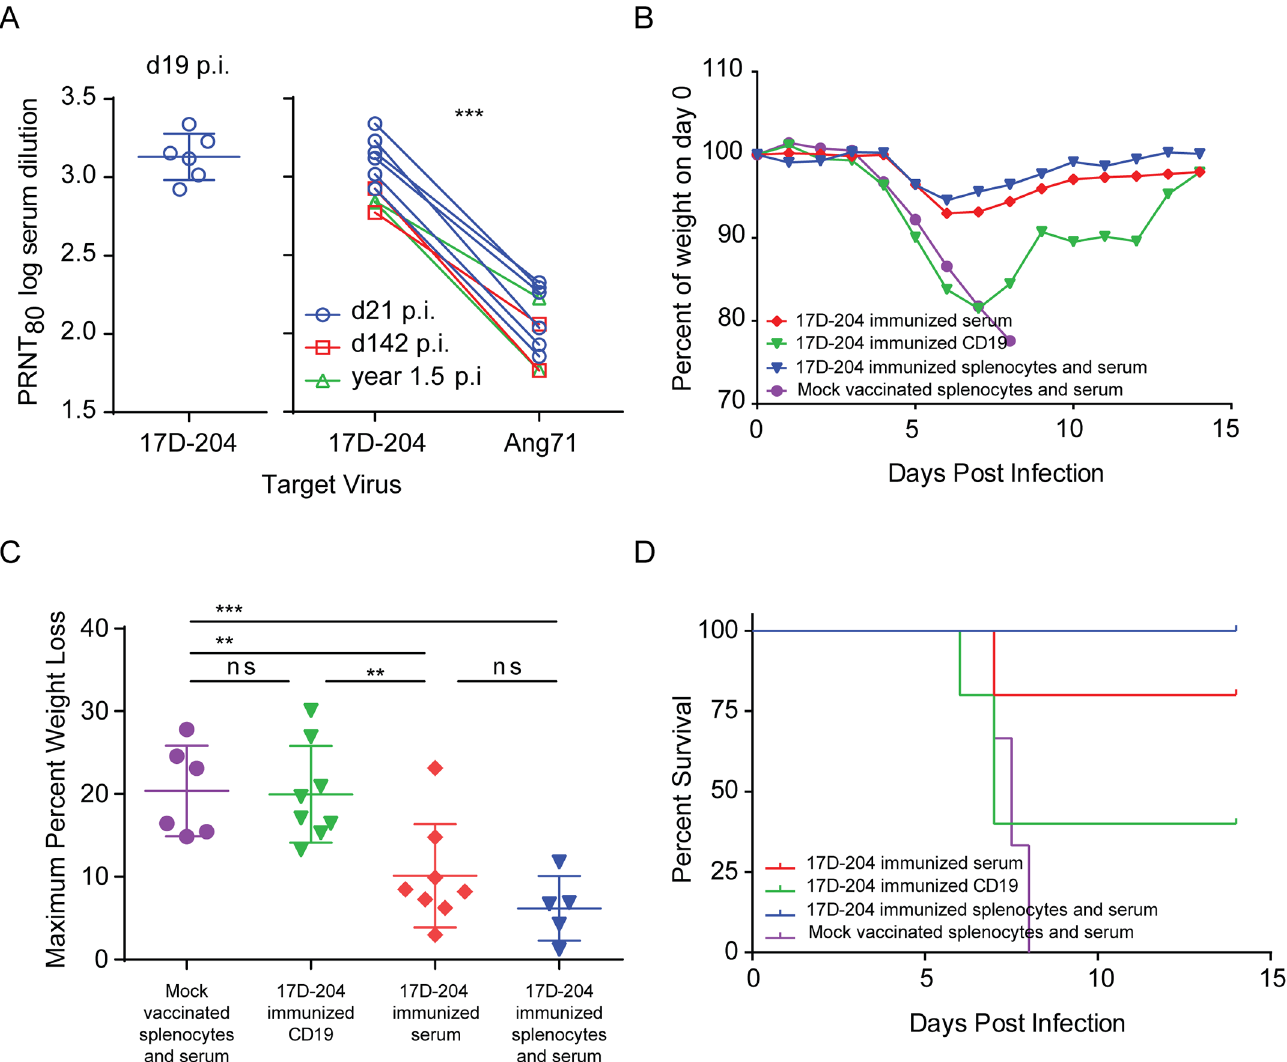
Fig 5. Transfer of convalescent serum or B cells from 17D-204 immunized mice to na ï ve mice partially protects against challenge with wtYFV. 5 – 6 week old mice were immunized s.c. with 17D-204. (A) serum was harvested and screened by PRNT 80 for 17D-204 and Ang71 neutralizing antibody at the indicated days post immunization [ *** , p = 0.0001 paired t-test]. (B-D) On d21 following immunization, spleens, lymph nodes and sera were collected. CD19+ cells were enriched according to S2 Fig and adoptively transferred into naive 8 week old mice. Some mice received passive transfer of sera and total splenocytes from 17D-204 or mock vaccinated animals. Twenty-four hours after the transfer, mice were challenged with Ang71 and monitored daily for (B) cumulative weight loss (C) maximum weight loss and (D) survival. Weight is expressed as a percentage of weight on d0 of challenge [ns, not significant; ** , p (cid:1) 0.005; *** , p (cid:1) 0.0005; One-way ANOVA with Tukey's multiple comparisons test]. Refer to Table 1 for statistics comparing percent of survival and numbers of animals. These data are the combined results of two independent